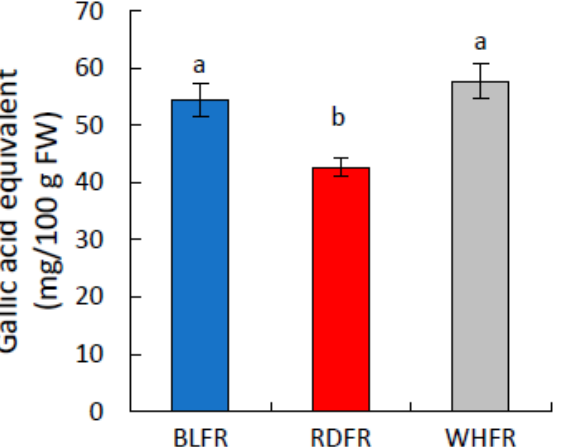
Figure 5. Influence of light quality on the total phenol concentration in fruits. Results are the mean ± SE ( n = 3). Different letters indicate significant differences at p < 0.05 by Tukey-Kramer’s test. BLFR, RDFR, and WHFR refer to blue, red, and white light-treated fruits, respectively.